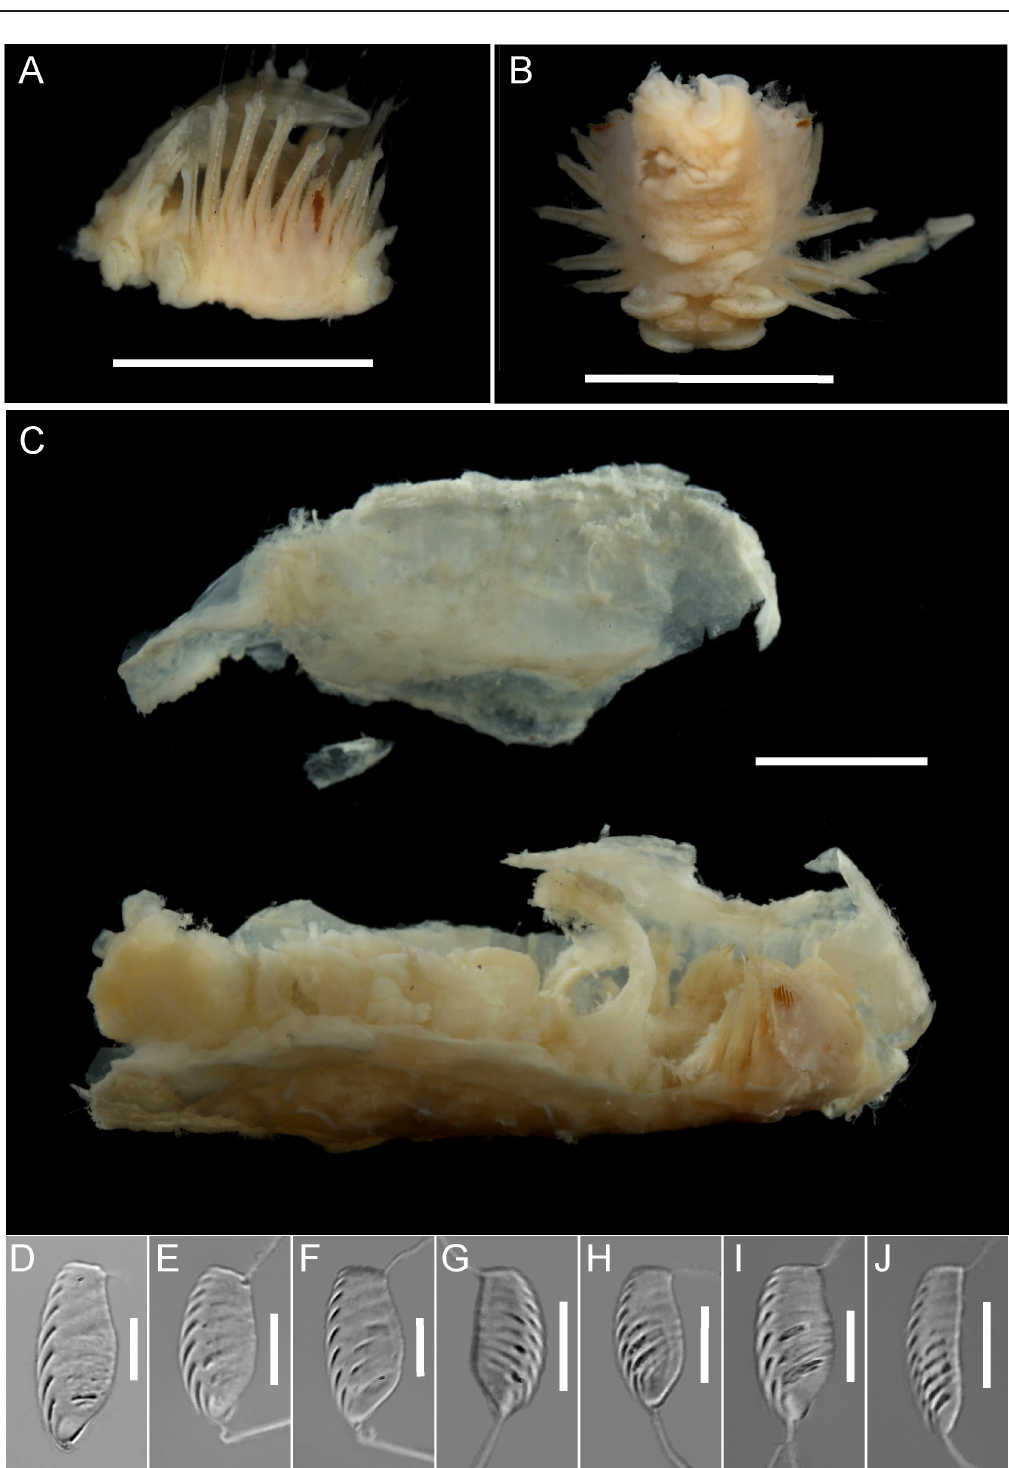
Fig. 1. Chaetopterus norvegicus M. Sars, 1835. A . Right lateral view of anterior fragment of a paralectotype NHMO C5877 (to segment B1). B . Ventral view of anterior fragment of a paralectotype NHMO C5877 (to segment B1). C . Top, tube fragment, bottom, lectotype specimen NHMO C7049 preserved within a fragment of tube. D –J . Uncini sampled from non-type, uncataloged LACM specimen Pol2 Z76/58. D . Uncinus of A9 neuropodium. E . Uncinus of B1 anterior neuropodial lobe. F . Uncinus of B1 posterior lobe. G . Uncinus of B3 piston torus. H . Uncinus of B3 ventral lobe. I . Uncinus of C1 lateral lobe. J . Uncinus of C1 ventral lobe. Scale bars: A–C = 5 mm; D–J = 20